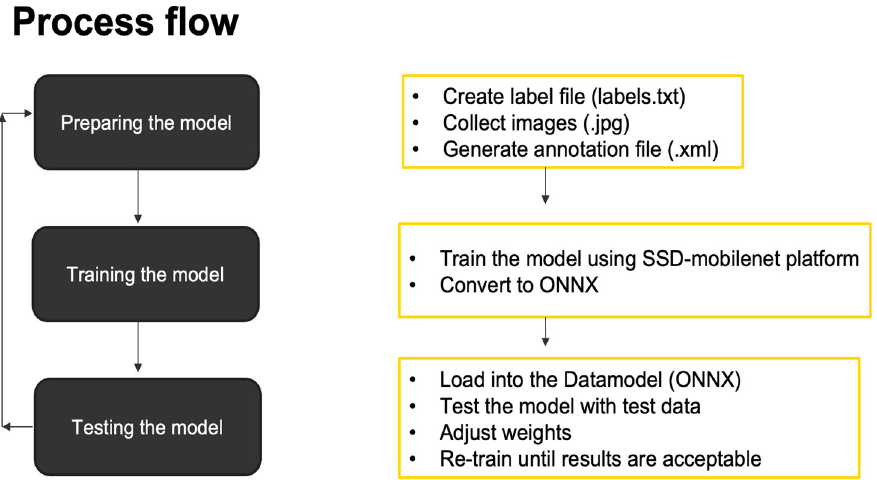
Figure 2. Model development process.